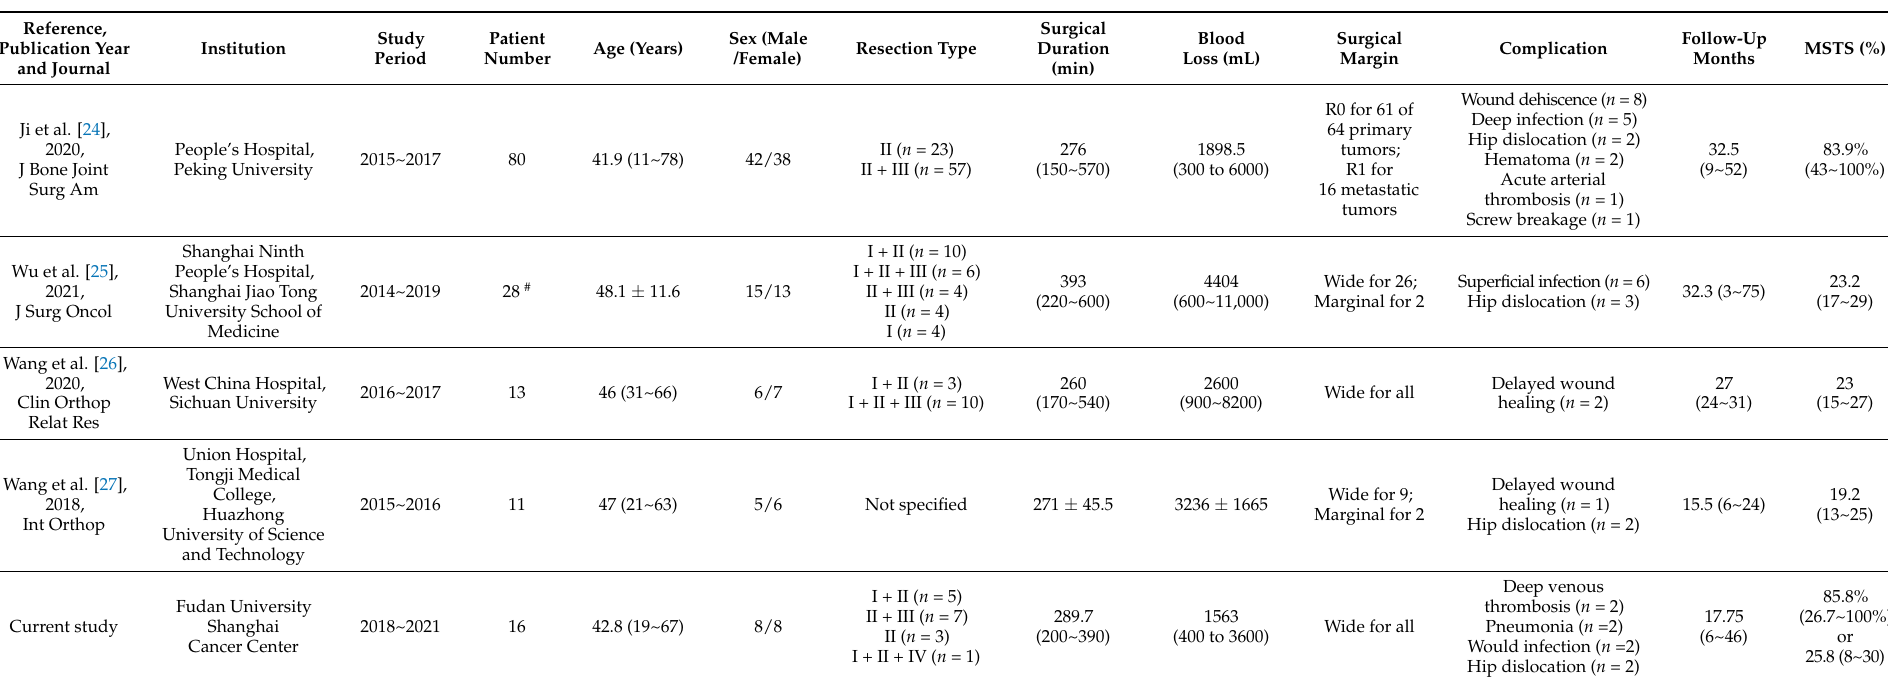
Table 3. Surgical characteristics and outcomes of 3D-printed prosthesis reconstruction after periacetabular tumor resection reported by large tertiary hospitals in